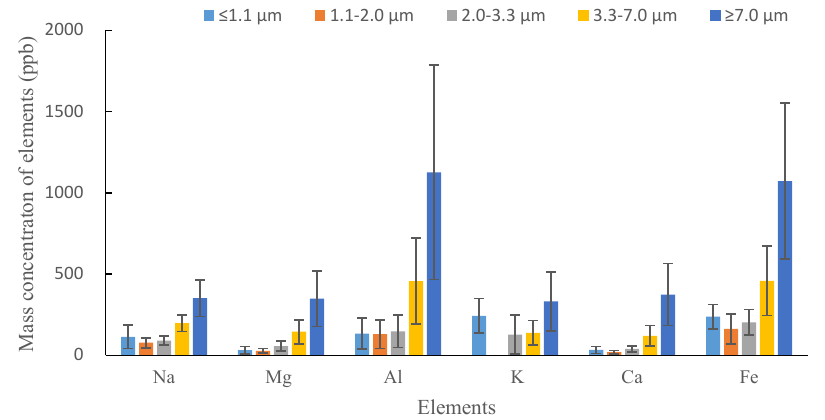
Figure 3. Mass concentration of crustal elements in the size-resolved particles. Fe, a typical redox sensitive element in airborne particles, was regarded both from crustal sources and anthropogenic sources. Considering that this element has strong redox abilities, a higher mass concentration of the Fe in the particles would play an essential role in allergenicity induced by the ambient particles. Mass levels of the Fe in the size-resolved particles were 238.83 ± 74.72, 162.59 ± 92.10, 203.79 ± 79.62, and 458.20 ± 213.90 ppb, re- spectively (except for PM > 7, which was 1073.32 ± 480.32 ppb). We reported that the mass concentration of Fe in Shanghai PM 2.5 was 1403.18 ppb (ng/mL) in the spring season [23] and mass concentration of iron in ambient fine particles was less than 500 ppb, which suggests that the Fe mass level in Shanghai’s air decreased significantly (Figure 3). The highest mass level of trace metal was Zn, followed by Mn, Pb, Ni, Cr, Cu, V, Ba, Sr, As, Se, Cd, and Cs (Figure 4). It was necessary to point out that, of these, Zn (57.53 ± 19.7), Pb (25.07 ± 13.63), Ni (15.88 ± 6.74), Cr (12.33 ± 9.55), and Cu (7.71 ± 5.76) have higher mass levels in the PM 1.1 compared to those in the other size particles. It was noted that the total mass concentration of Fe, Cr, Mn, Ni, Cu, Zn, Ba, and Pb were more than 20 ppb, while other trace elements, such as V, Co, Ni, Cu, Zn, Ga, As, Se, Rb, Sr, Cd, and Cs, were lower than 20 ppb. The relationships of elements with mass concentrations less than 20 ppb with the Pla a3 are not discussed in this study.